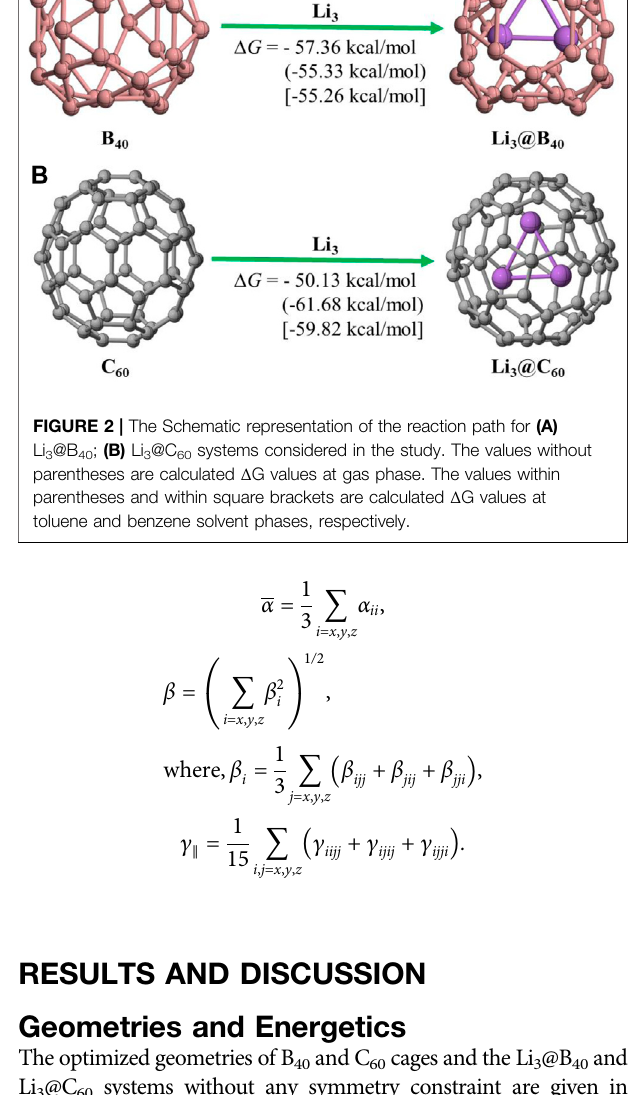
Figure 1 . The B 40 and C 60 cages have D 2 d and C 2 h point groups of